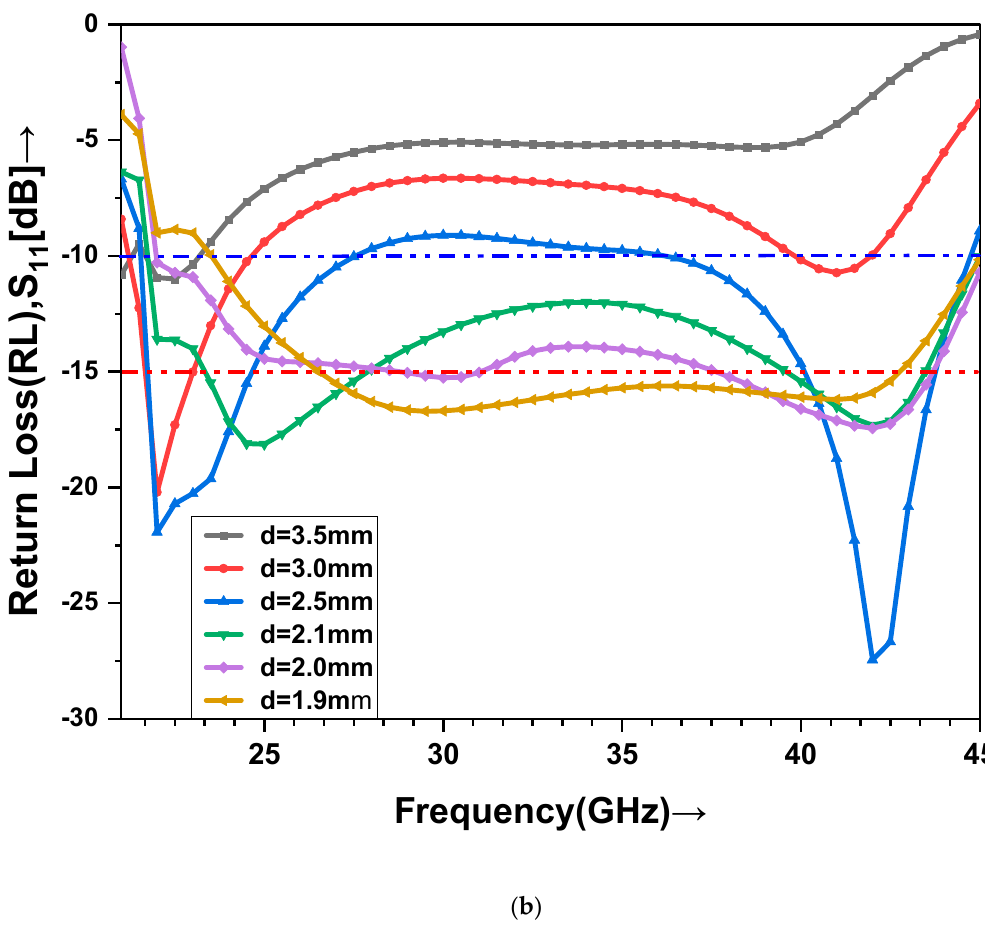
Figure 3. Effect of back-short distance variations on ( a ) IL and ( b ) RL. Table 2. Effect of fish-tail width variations with H Slot = 3 h.